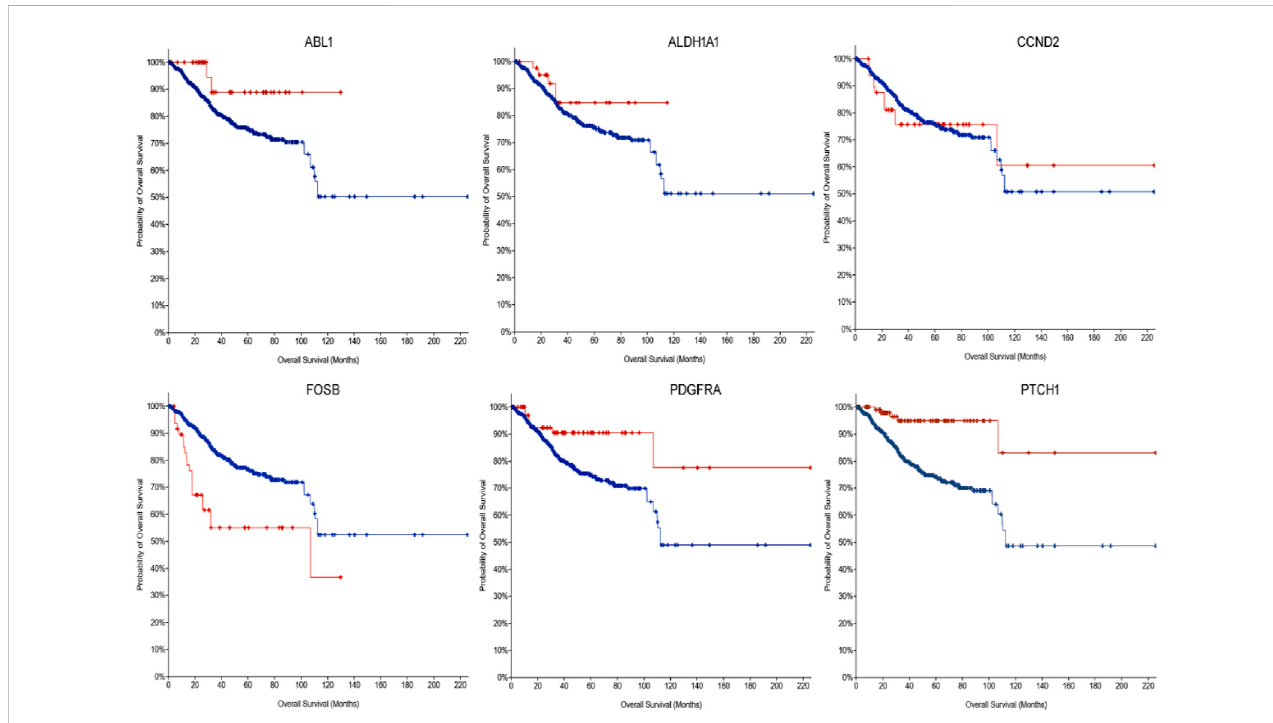
FIGURE 4 TheKaplan-Meiersurvivalcurveforthedysregulatedhubgeneasprognosticindicatorinendometrialcancers(diseasesurvivalinmonths). ABL1 Logrank